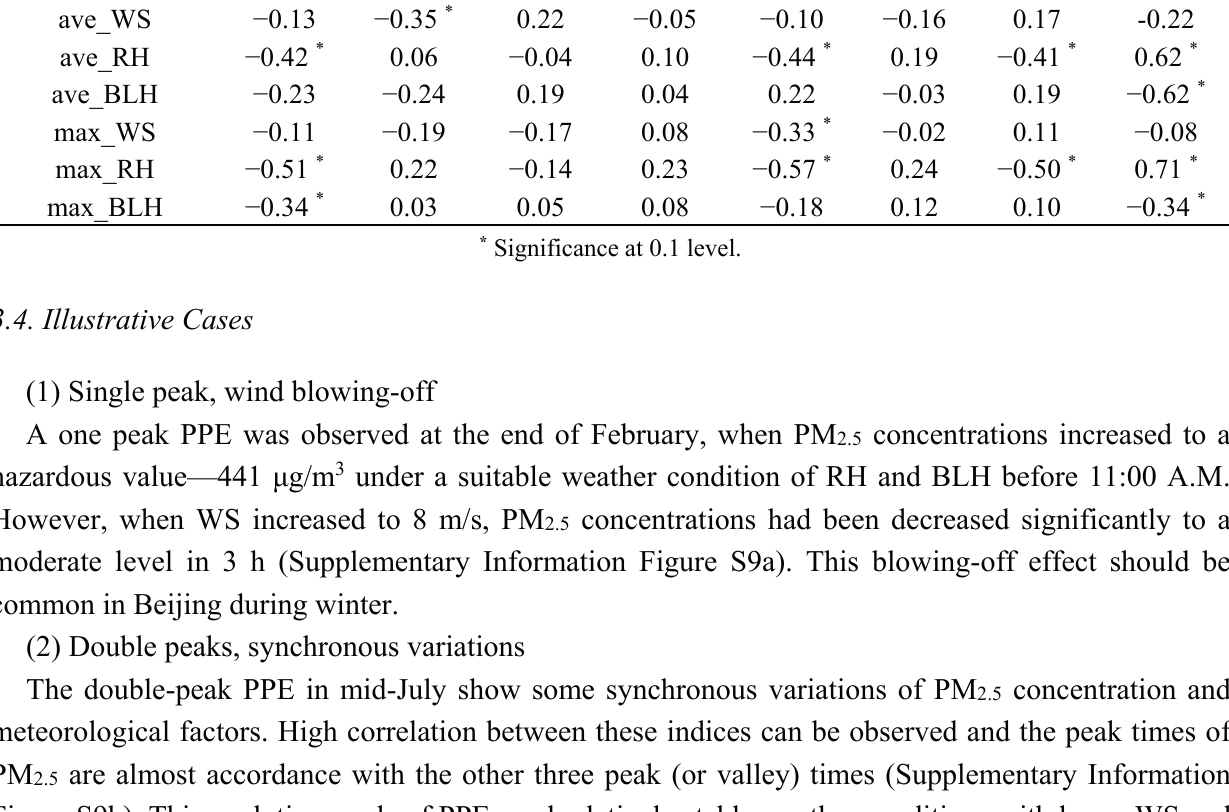
Table 7. Correlations between weather factors and rise/fall pattern in each category of evolution process. One peak Double-Peak Triple-Peak Multi-Peak Correlation Rise Fall Rise Fall Rise Fall Rise